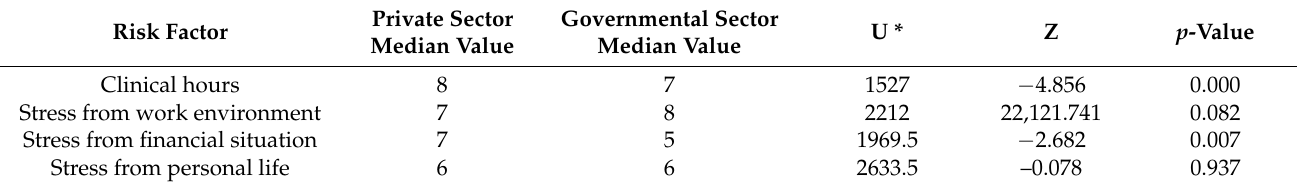
Table 6. A comparison of work environment risk factors between private and governmental practice.